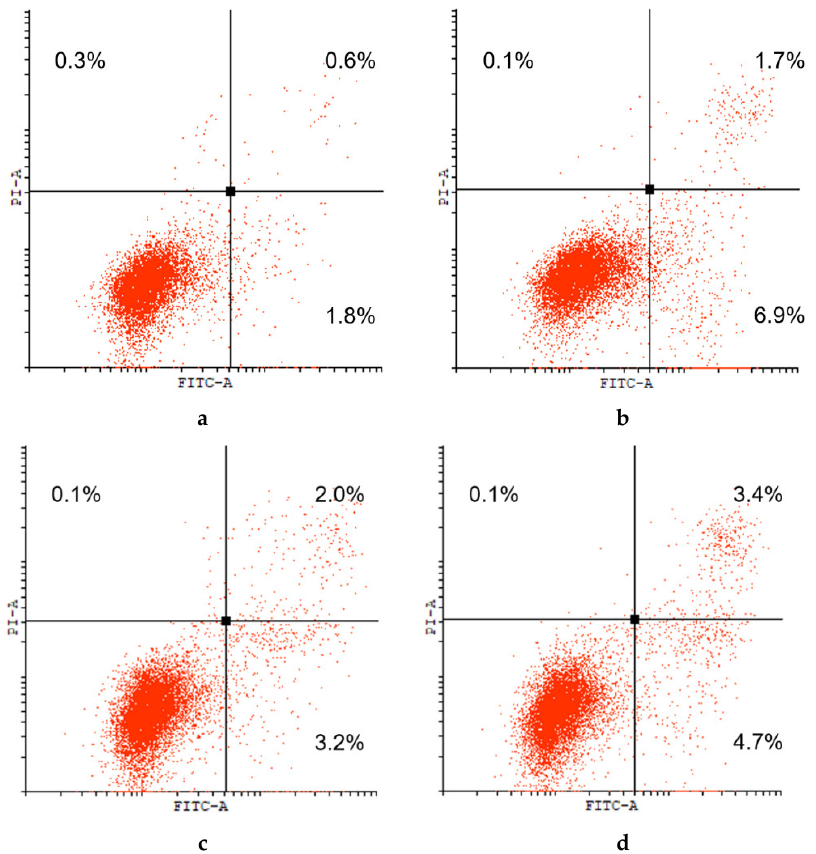
Figure 5. Percentages of necrotic (upper left), early apoptotic (lower right), and late apoptotic (upper right) K562 ( a , b ) and K562/iS9 ( c , d ) cells in the control experiments ( a , c ) and after exposure to complex 3b ( b , d ) for 20 h.